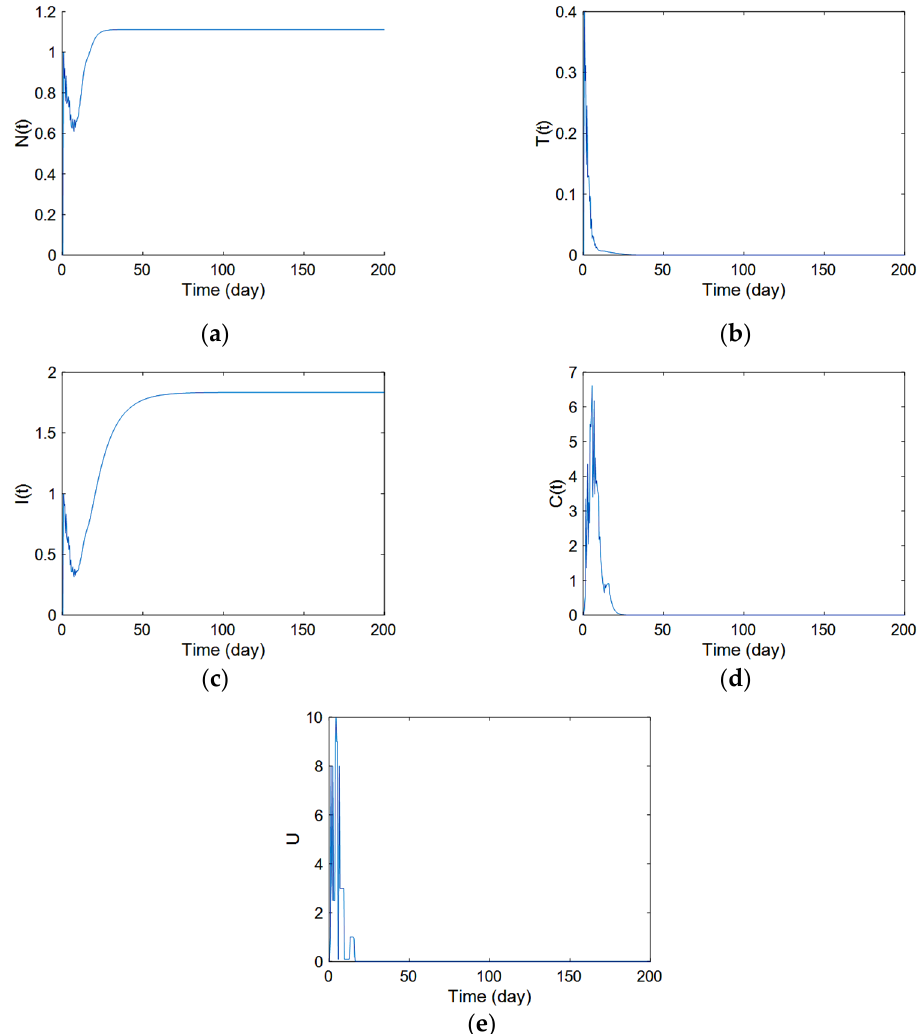
Figure 7. The result of simulation using the proposed control method for elderly patient with un- certainty. ( a ) Normal-cells ( b ) Tumor-cells ( c ) Immune-cells ( d ) Concentration of cells ( e ) Control action.